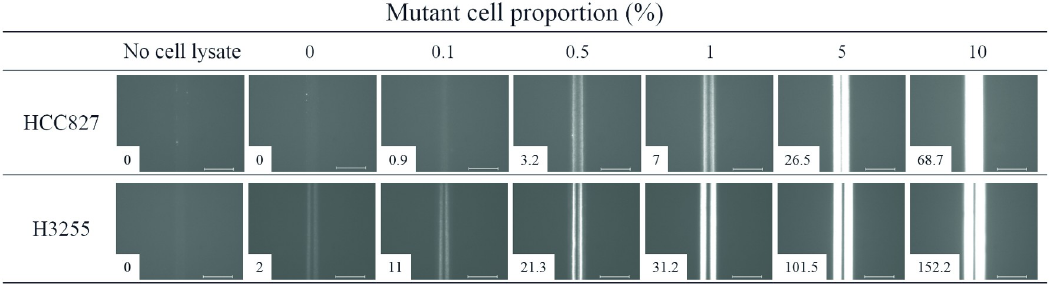
Fig 2. Representative fluorescence images after immunoassays of lysates containing mixed populations of mutant EGFR cells. Fluorescence intensity measured by a fluorescence immunoassay reader is indicated. Scale bars = 100 μ m.